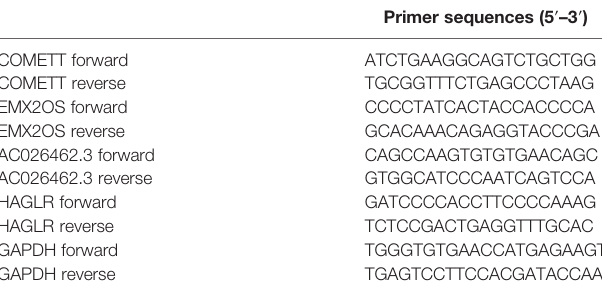
Primer sequences (5 ′ – 3 ′